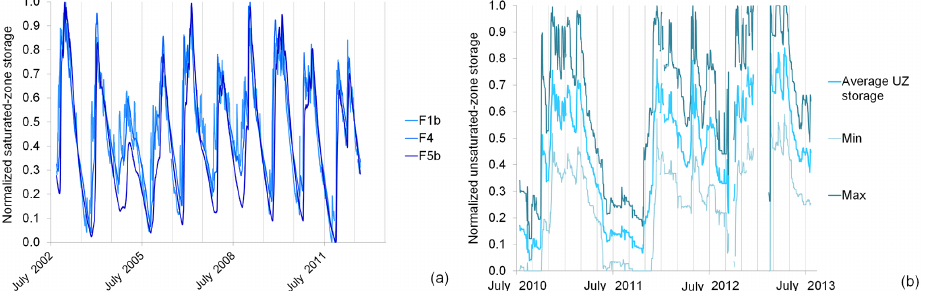
Figure 2. Normalized (a) groundwater levels for piezometers in the hillslope (F4 and F5b) and in the riparian zone (F1b) and (b) average, maximum and minimum unsaturated-zone storages for all the sensors in the two profiles in the Kerrien